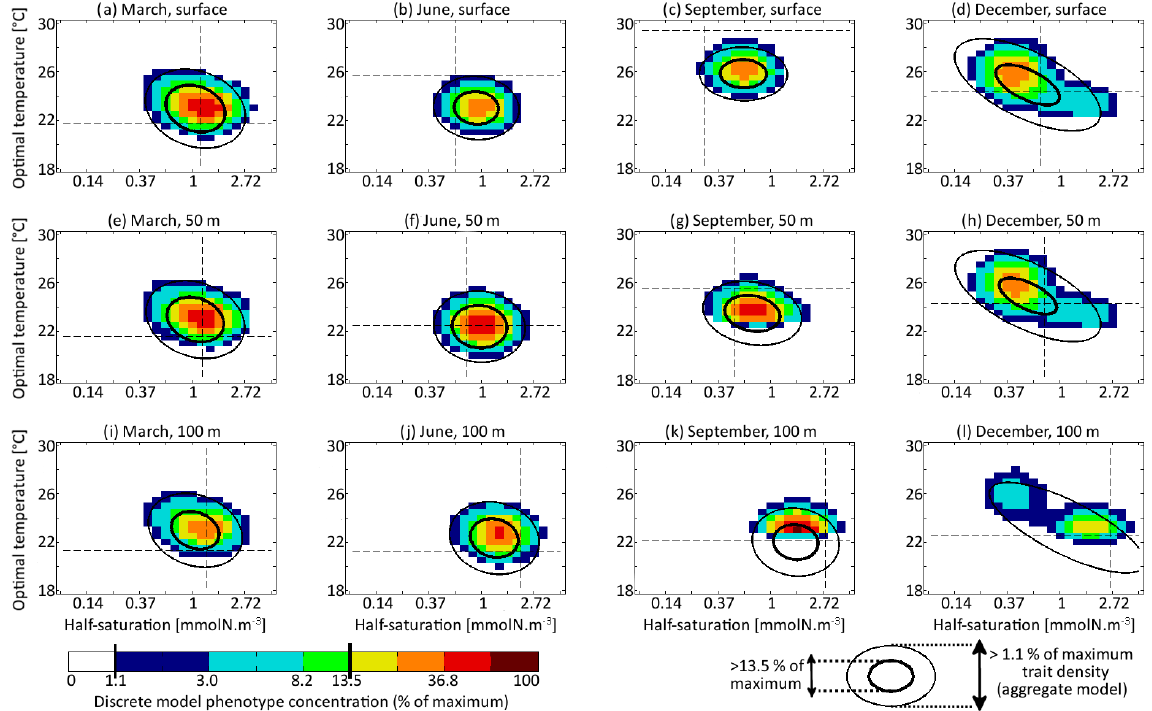
Figure 7. Concentrations of each phenotype of the multi-phenotype model (colour) compared with lines of equal density of the aggregate model ( ν x = 0 . 001 and ν y = 0 . 01 ◦ C 2 ). Subplots correspond to days 71, 161, 251, and 341 and depths of 0, 50, and 100m. Dashed lines indicate the optimal competitor. Table 3. Convergence time and various properties of SPEAD 1.0 simulations with different mutation rates. (cid:16) V (cid:17) ν x ν y Convergence time max Out of range Bimodality Adapts faster 2 ν – ( ◦ C 2 ) (years) (generations) (discrete model) with two traits 0